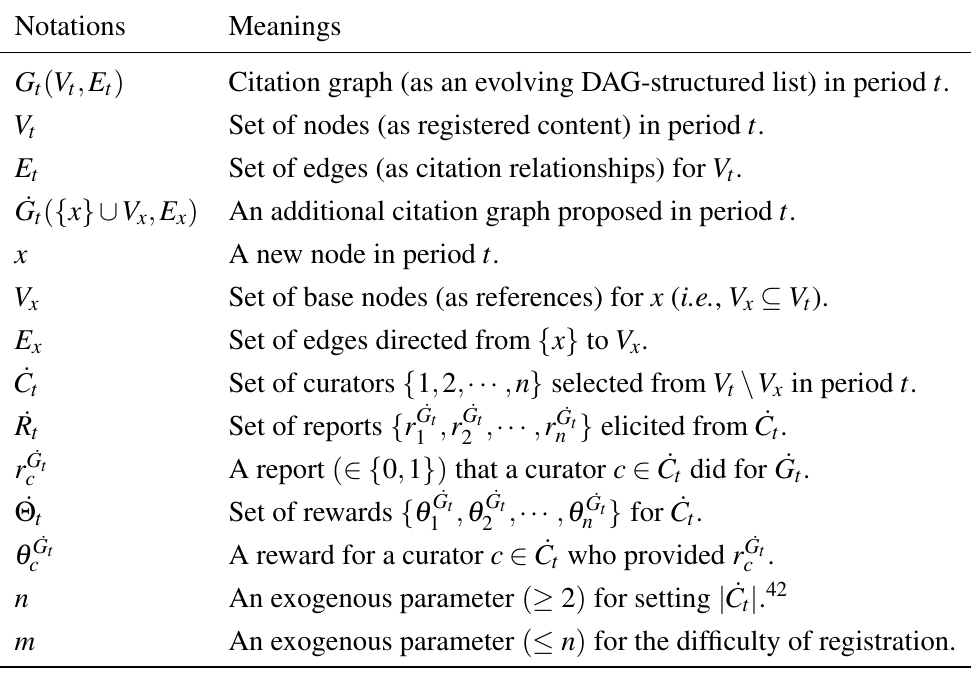
Table 1. Notations for the state transition in